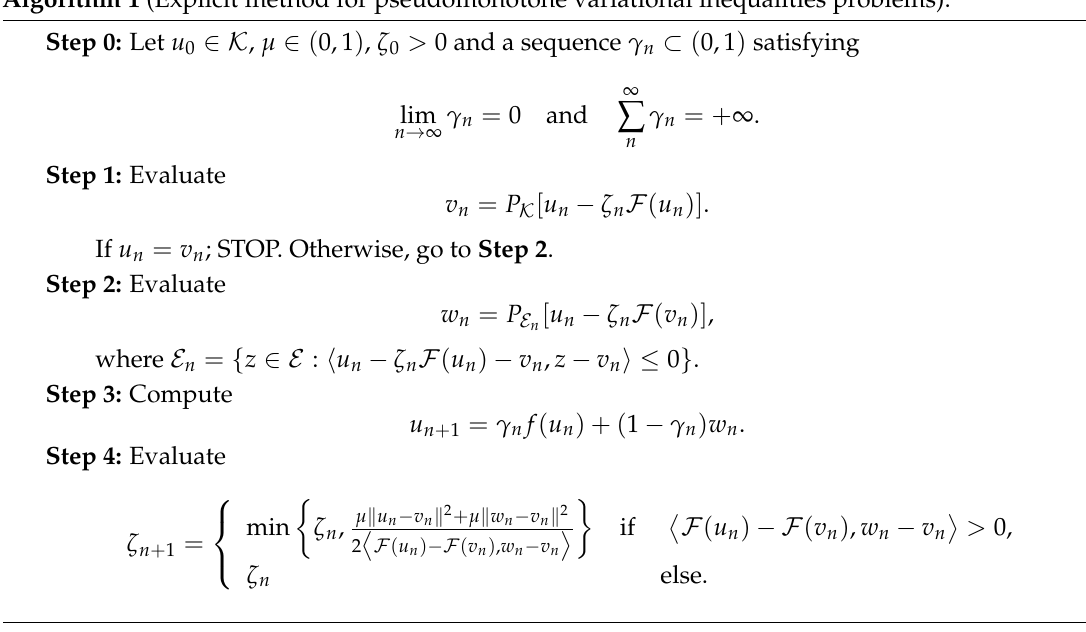
Algorithm 1 (Explicit method for pseudomonotone variational inequalities